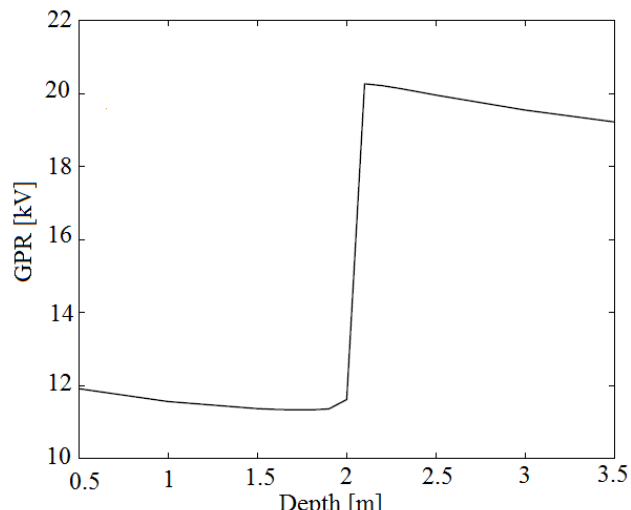
Fig. 13 GPR versus depth ( D ).